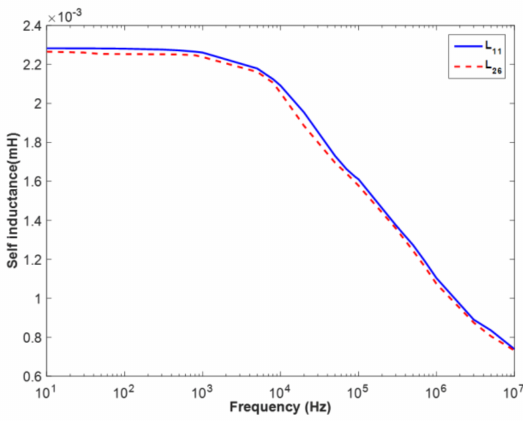
Figure 5. The frequency-dependent self-inductances of the transformer winding, L 11 and L 26 .